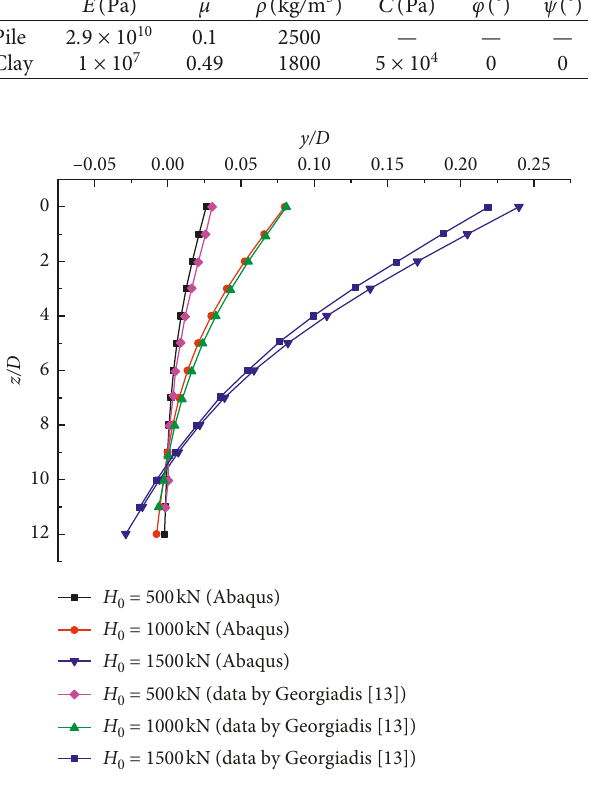
Figure 2: Displacement curve for comparison.